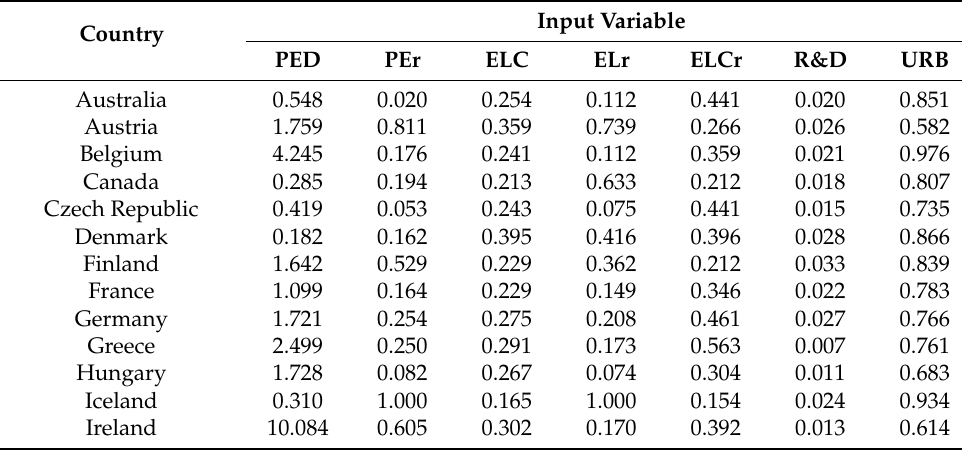
Table A3. Country means of the input variables over the entire